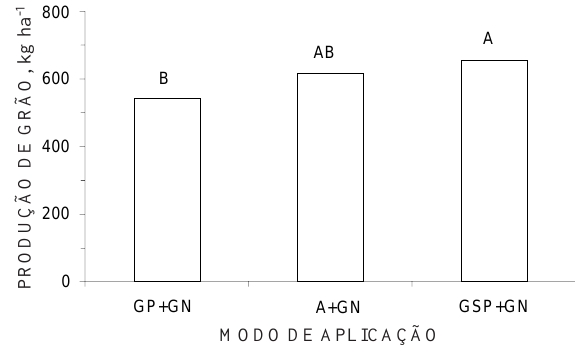
Figura 1. Efeito dos modos de incorporação de calcário por meio da gradagem pesada (GP + GN), aração (A + GN) e da gradagem superpesada (GSP + GN) na produção de grãos da cultura da aveia preta (GN = grade niveladora). (Média para todas as doses de